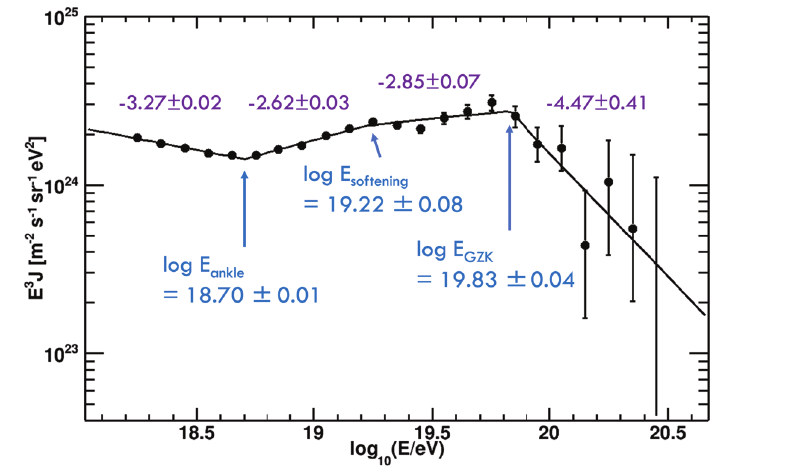
Figure 4. Softening spectral feature in 14-year SD data. The data is represented with the black points with error bars, and a fit to the broken power law having three break points is shown with the black solid line. The detailed results are written on the energy spectrum, including spectral indices and break